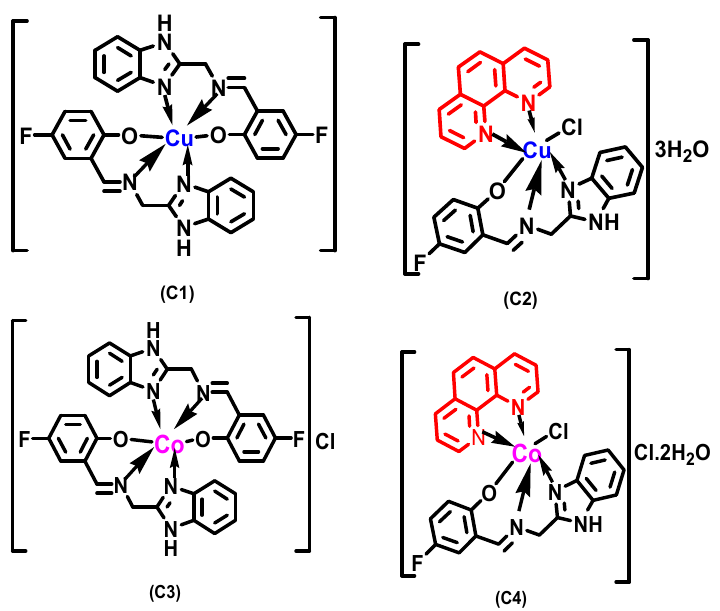
Figure 1. Proposed structures of metal complexes ( C1 – C4 ).